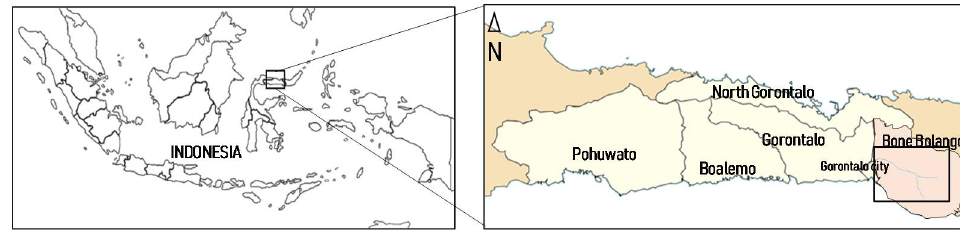
Figure 1. Location of Gorontalo in Indonesia ( left ) and map of Gorontalo ( right ) with the study area along the Bone River enclosed in a black rectangle.